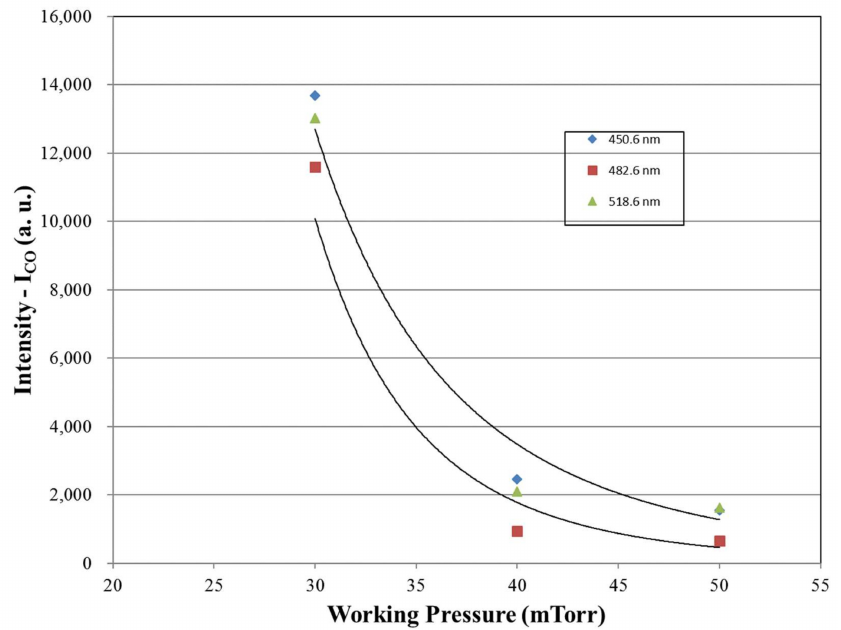
Figure 10. OES intensity of CO (ICO) vs. working pressure. CO peaks appear at 450.6, 482.6, and 518.6 nm.